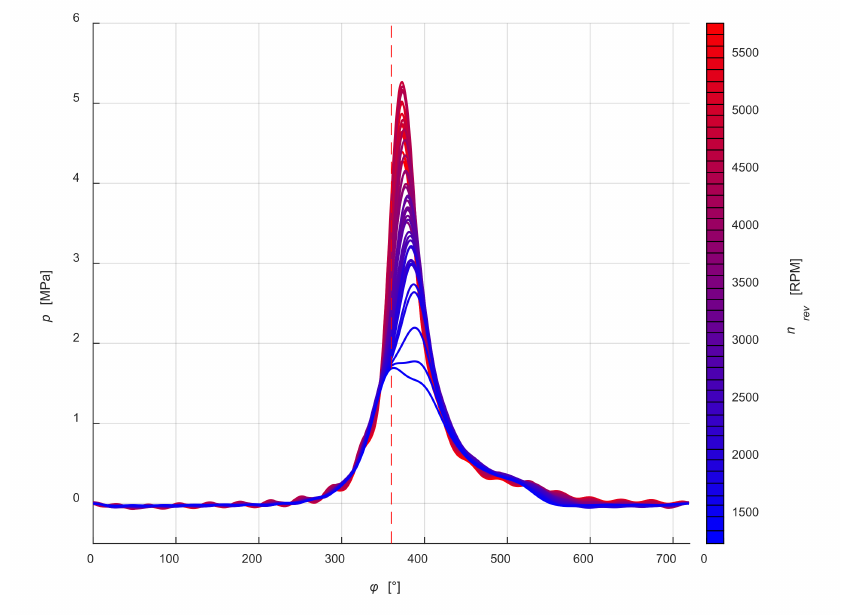
Figure 15. Comparison of pressure changes, determined by a Fourier series for selected rota- tional